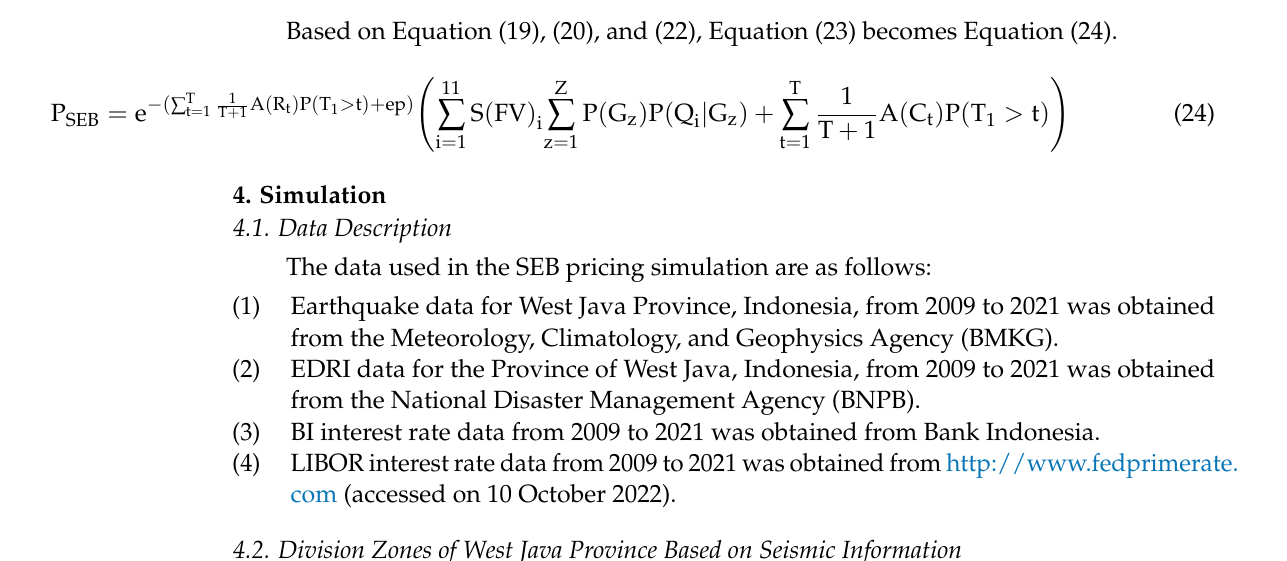
Figure 5. West Java Province EDRI Score (Source: BNPB) Figure 5 shows that Kota Banjar has the highest EDRI score, while Indramayu has the lowest. The high-category EDRI is in the interval [12. 01, 21. 6], and the moderate cat- egory is in [6.97, 11. 06]. The covered area is classified into regions with high, medium, and low earthquake risk indexes based on the EDRI score, as shown in Table 3. Table 3. The results of clustering subregions based on EDRI